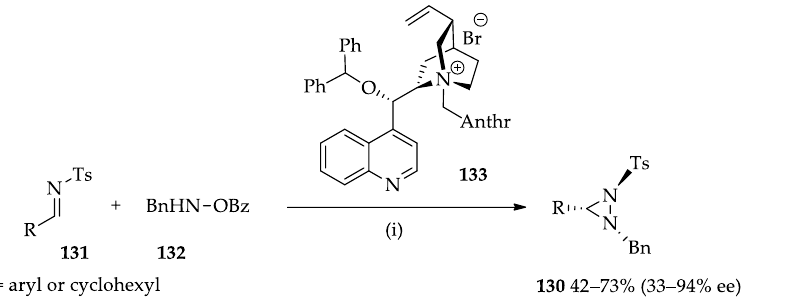
Scheme 9. Synthesis of diaziridines with N - and/or C -cyclopropyl substituents 125 and/or 126 . Conditions: (i) excess of the corresponding amine, MeOH, 0–5 °C; (ii) K 2 CO 3 /CHCl 3 , ~20